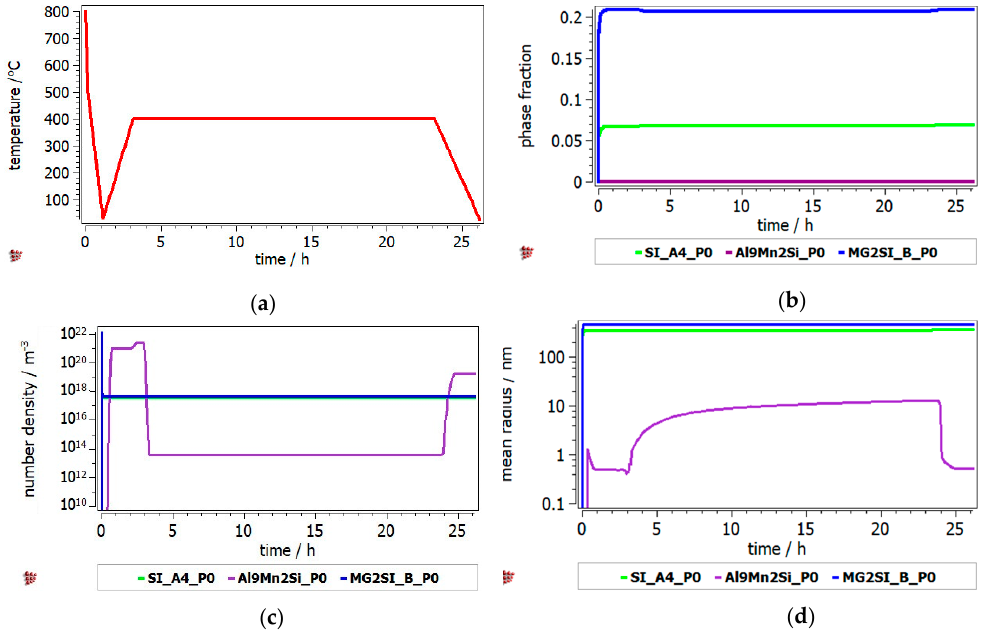
Figure 10. Precipitation kinetics in Al 3.4 Cu 0.5 Si 0.2 Zn 0.5 Mg 0.2 alloy during annealing at 400 ºC, for 2 h: ( a ) heat treatment diagram, ( b ) precipitate phase fraction versus time, ( c ) precipitate number density versus time, ( d ) precipitate mean radius versus time.